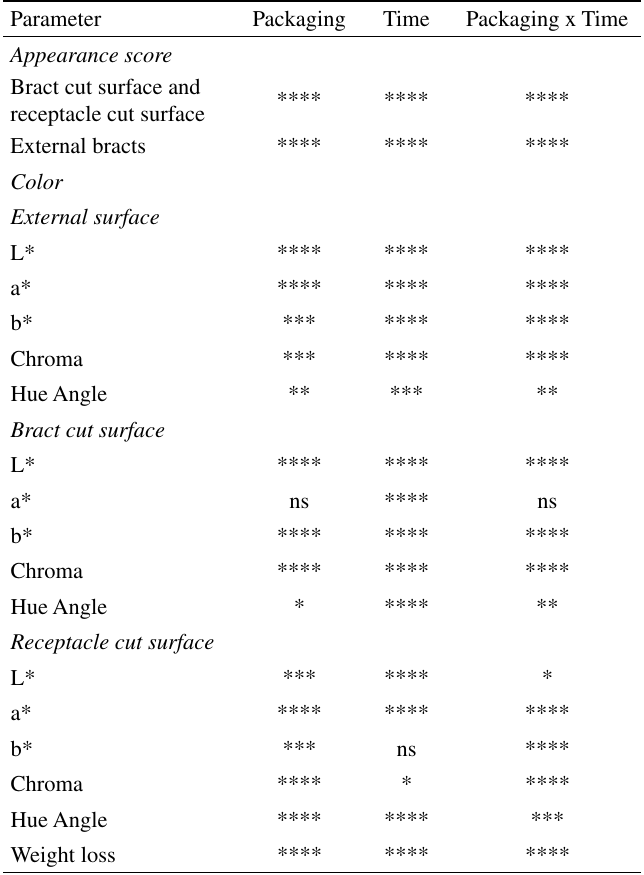
Table 2 - Results of ANOVA test for treatment and time of storage on quality attributes of fresh-cut artichoke quarters during stor- age in different